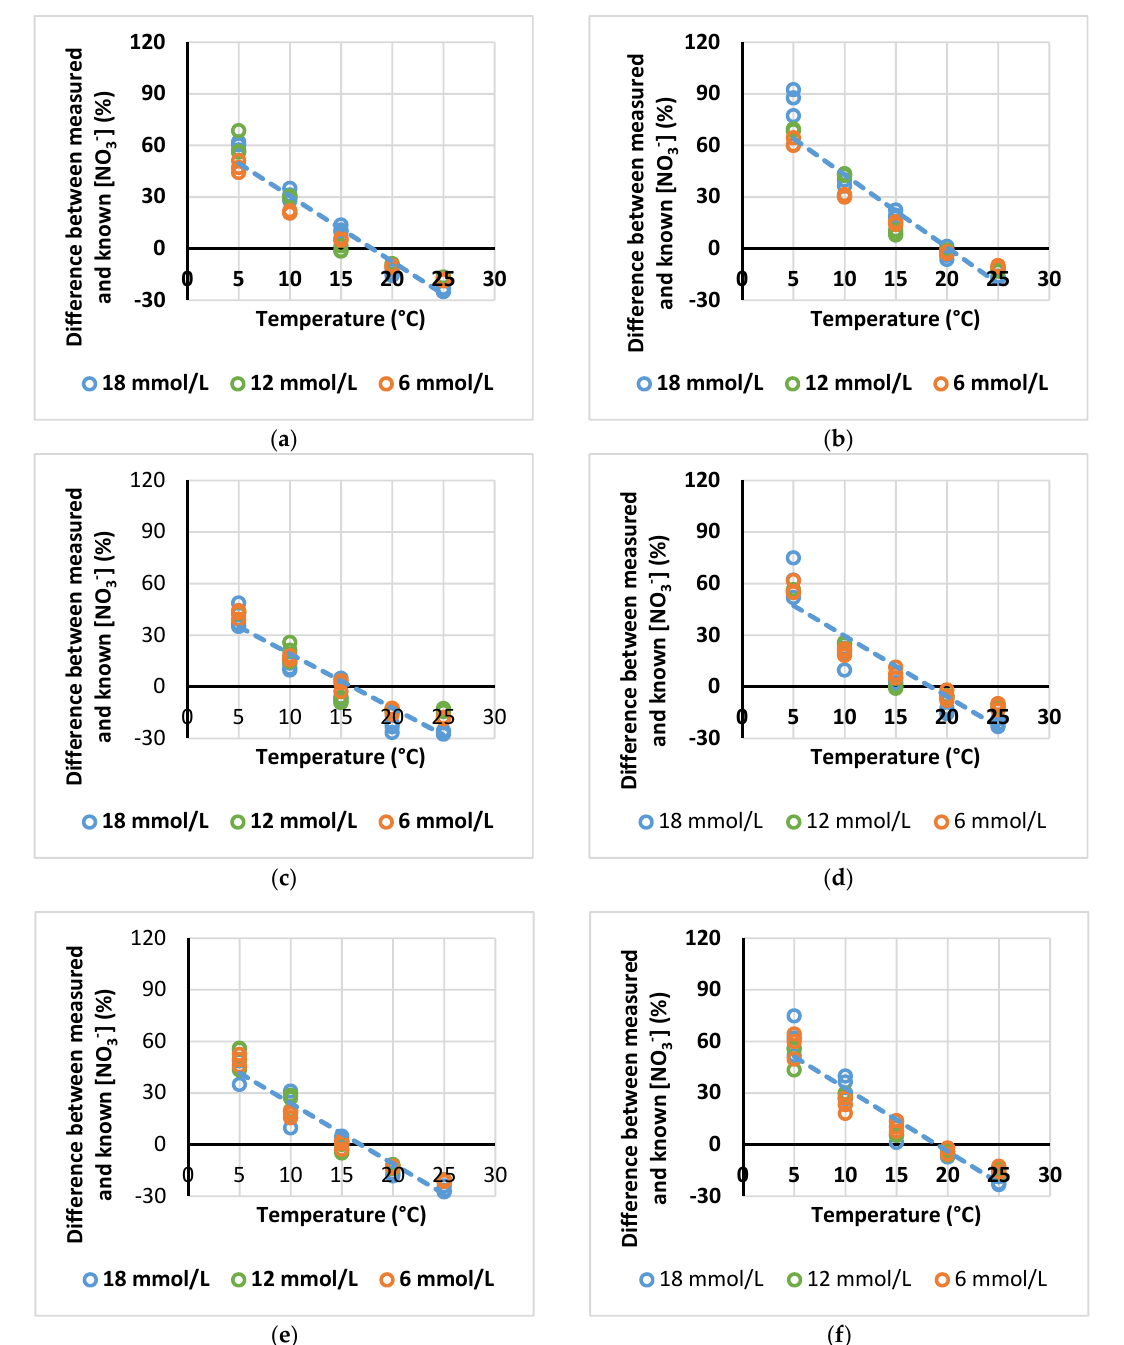
Figure 2. The relationship between the relative difference (expressed as percentage) between [NO 3 − ] measured with an ion selective electrode (ISE) meter and the known [NO 3 − ], and the temperature of the sample. Measurements were made with the two different ISE meters (LAQUAtwin models NO3-11 and B343) in aqueous solutions prepared with three NO 3 − different salts, with concentrations of 6, 12 and 18 mmol NO 3 − L − 1 . There were six different combinations of ISE meter and source of NO 3 − : ( a ) LAQUAtwin NO3-11 and KNO 3 ; ( b ) LAQUAtwin B343 and KNO 3 ; ( c ) LAQUAtwin NO3-11 and Ca(NO 3 ) 2 ,; ( d ) LAQUAtwin B343 and Ca(NO 3 ) 2 ; ( e ) LAQUAtwin NO3-11 and NaNO 3 ; and ( f ) LAQUAtwin B343 and NaNO 3 . ISE measurements were conducted at sample temperatures of 5, 10, 15, 20 and 25 °C. The lines of the linear regression equations describing the relationships are pre- sented in each panel for 5–25 °C (blue, dotted line). The equations, R 2 values, and the values of the intercept with the x-axis are presented for 5–25 °C, for each combination of ISE meter and NO 3 − source, in Table 1.